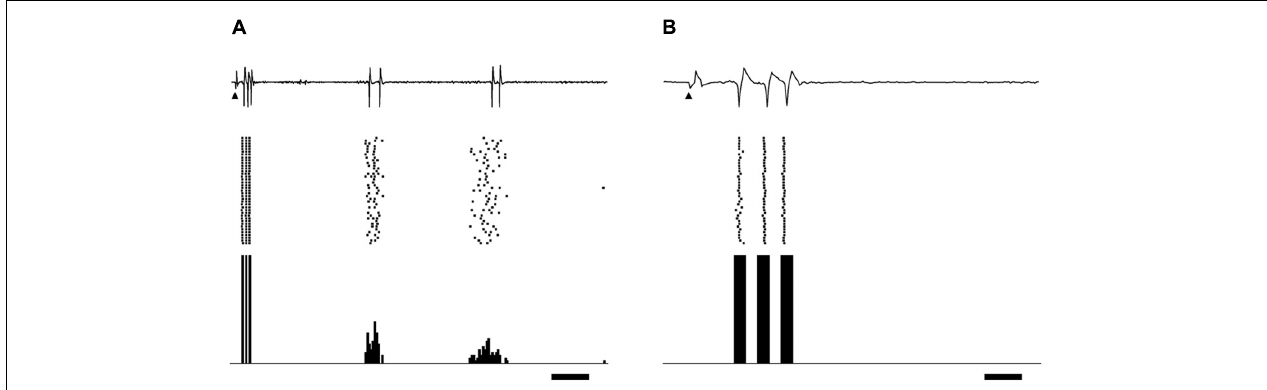
FIGURE 1 | Example of relay cell response in dLGN evoked by biphasic pulses of STS. Extracellular recording waveforms (upper row), raster plots (middle row), and peri-stimulus time histograms (lower row) are shown. (A) STS of 300 µ A evoked burst discharges on off-center Y-cells. The distance between the central point of the RF center and the stimulating electrode was 1.28 ◦ . Arrowheads indicate the stimulus onset. Scale bar, 20 ms. Panel (B) is an enlargement of panel A on the time axis to show the spikes in the first burst. The scale bar, 3 ms.